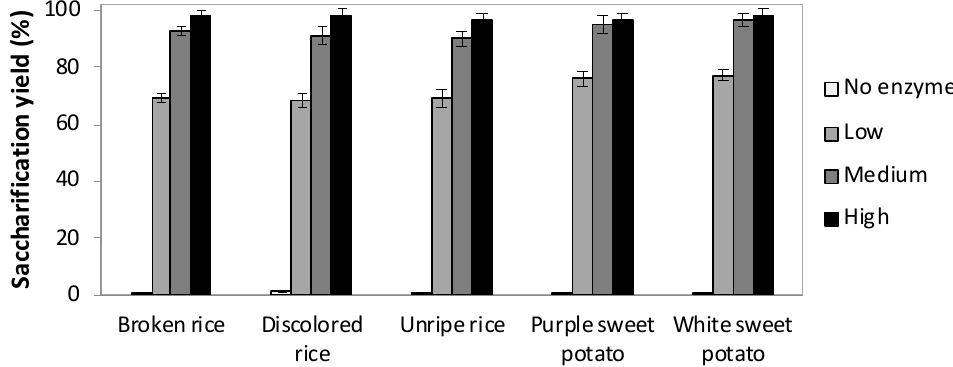
Figure 1. Saccharification yields at 96 h of 3% ( w / v ) starchy substrates with three different loadings of STARGEN ™ 002: 1.06 (low), 1.42 (medium) and 1.77 (high) µ L per g of starch. Values represent the mean of three replicates and error bars represent the standard deviation.